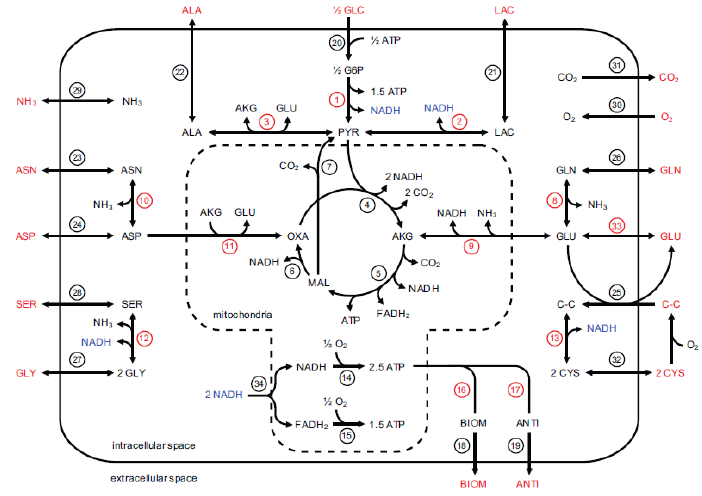
Figure 1. Metabolic pathways of CHO cell model. The 34 reactions are indexed. 14 extracellular metabolites, except for CO 2 and O 2 , are modeled.